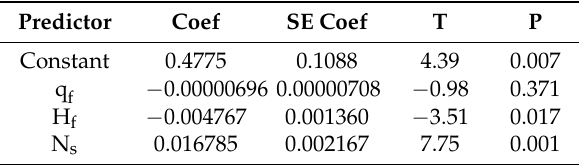
Table 15. Regression equation coefficients.